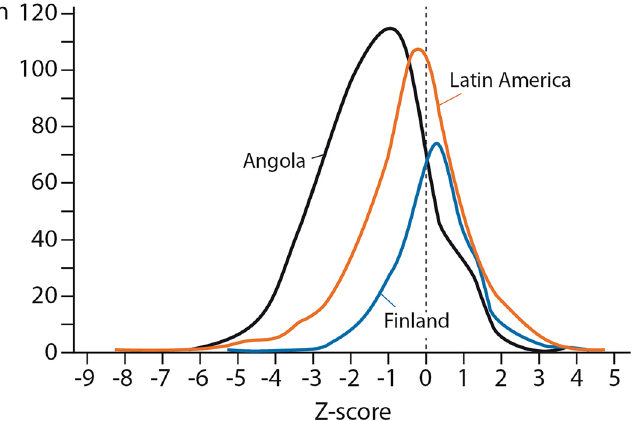
Figure 1. Distribution of weight-for-age z-scores in Finland, Latin America, and